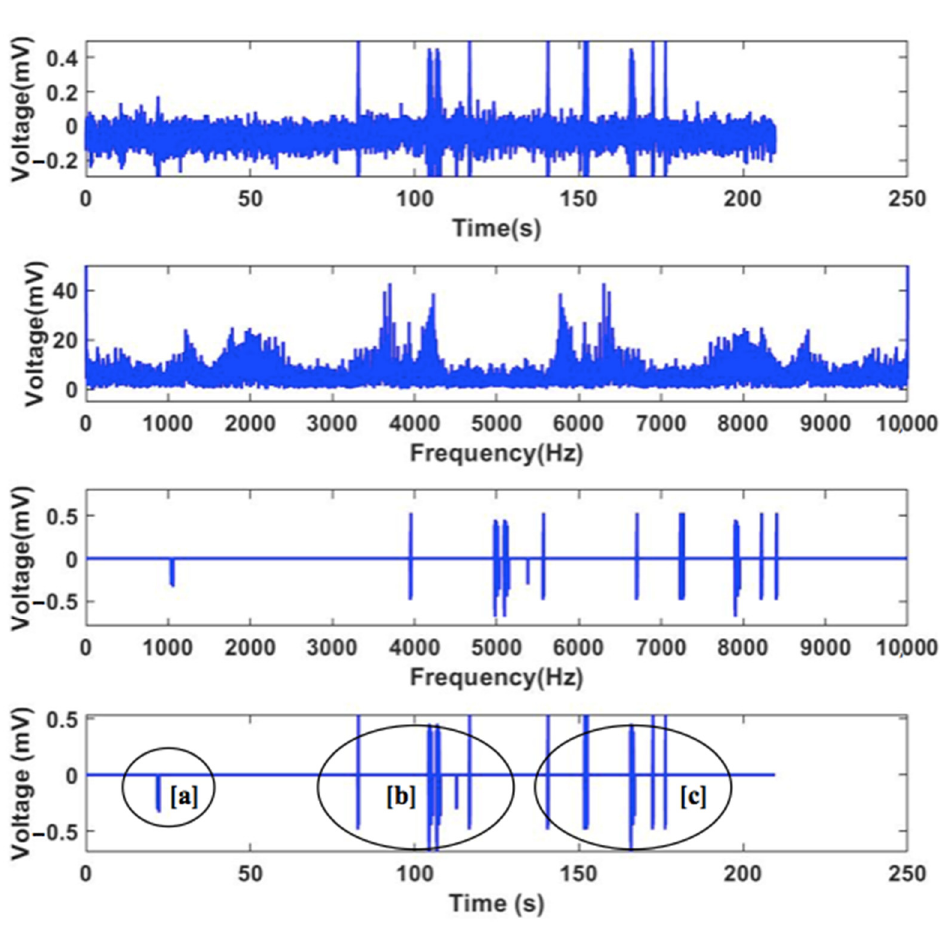
Figure 13. GFRP electromagnetic emitted voltage during mechanical loading and noise filter electromagnetic emitted voltage during mechanical loading where the slight charge release is labeled as [a]; upon further loading, crack propagates and more charge release was observed at both sections [b] and [c].